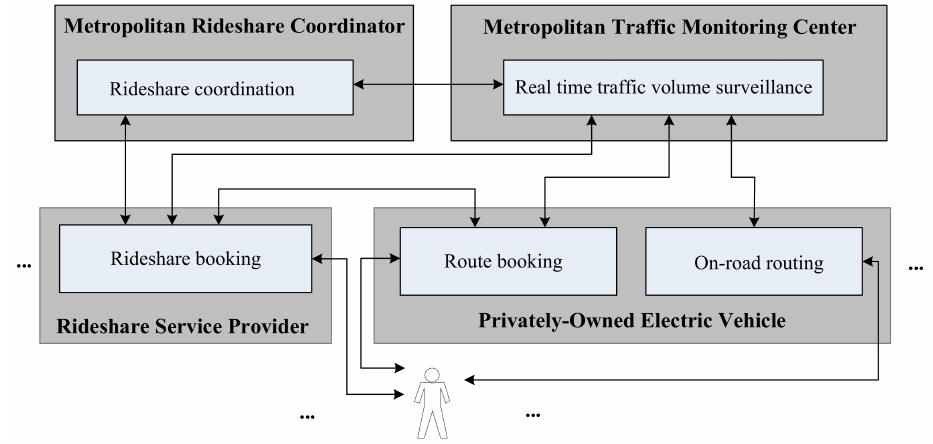
Figure 1. Integrated framework of traffic congestion prevention and cooperative rideshare dispatch of SAEV